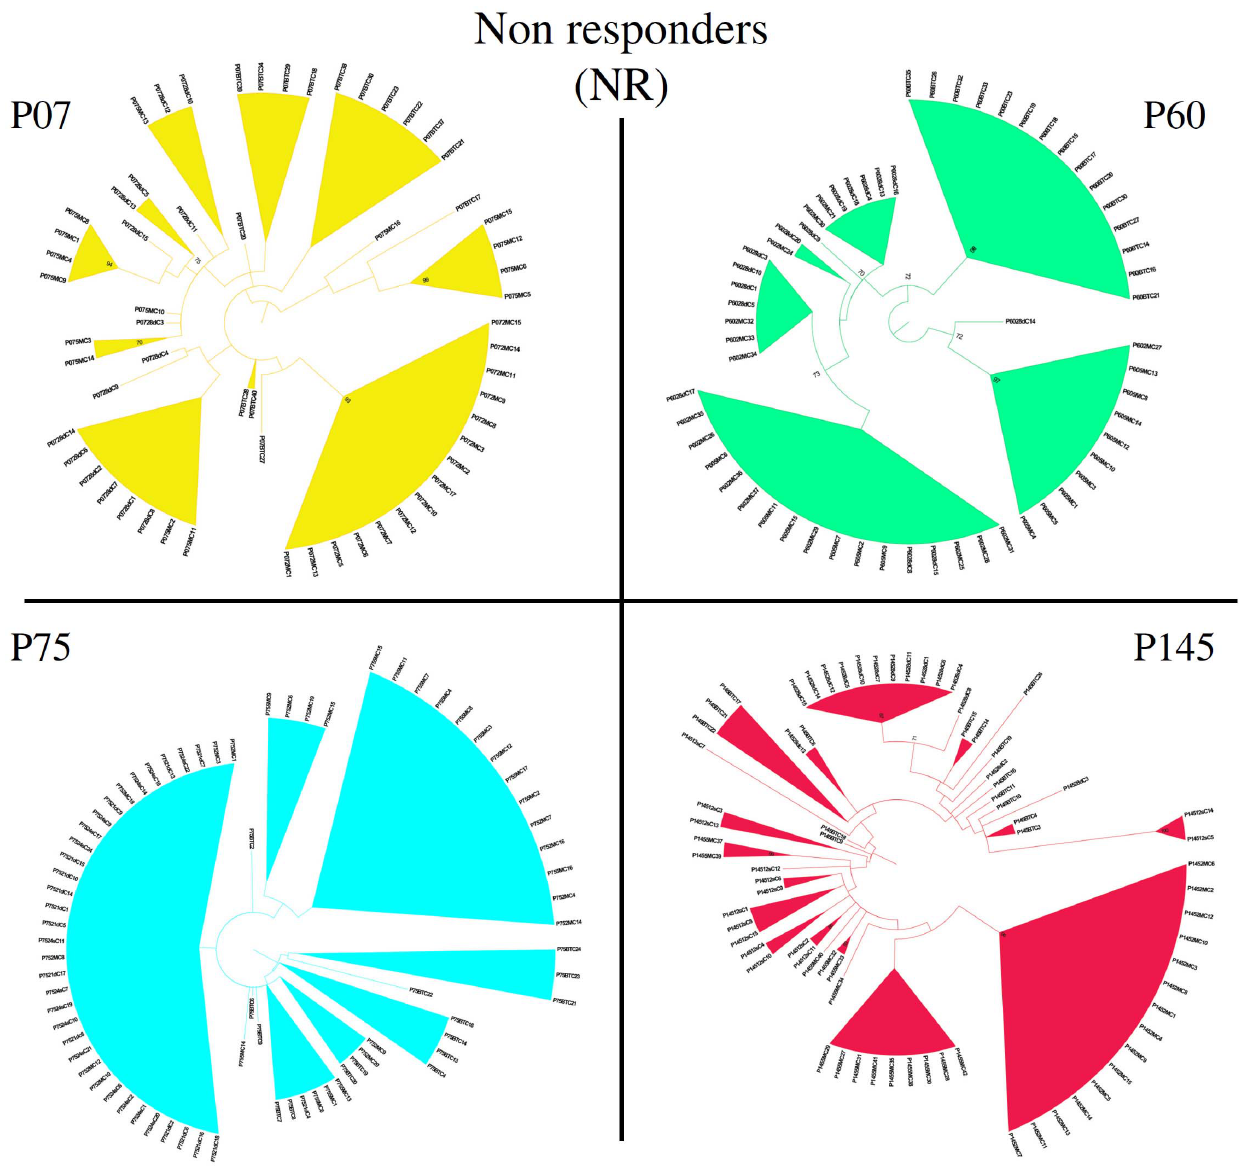
Figure 9. Non-responders individual phylogenetic trees. Unrooted Maximum-Likelihood phylogenetic trees from NR patients were constructed with HKY85 substitution model including Gamma distribution parameter (HKY + G). Bootstraps were performed with 1000 replicates. Values above 70% were considered significant. BT - Before treatment; w - weeks; d - days; m - months.